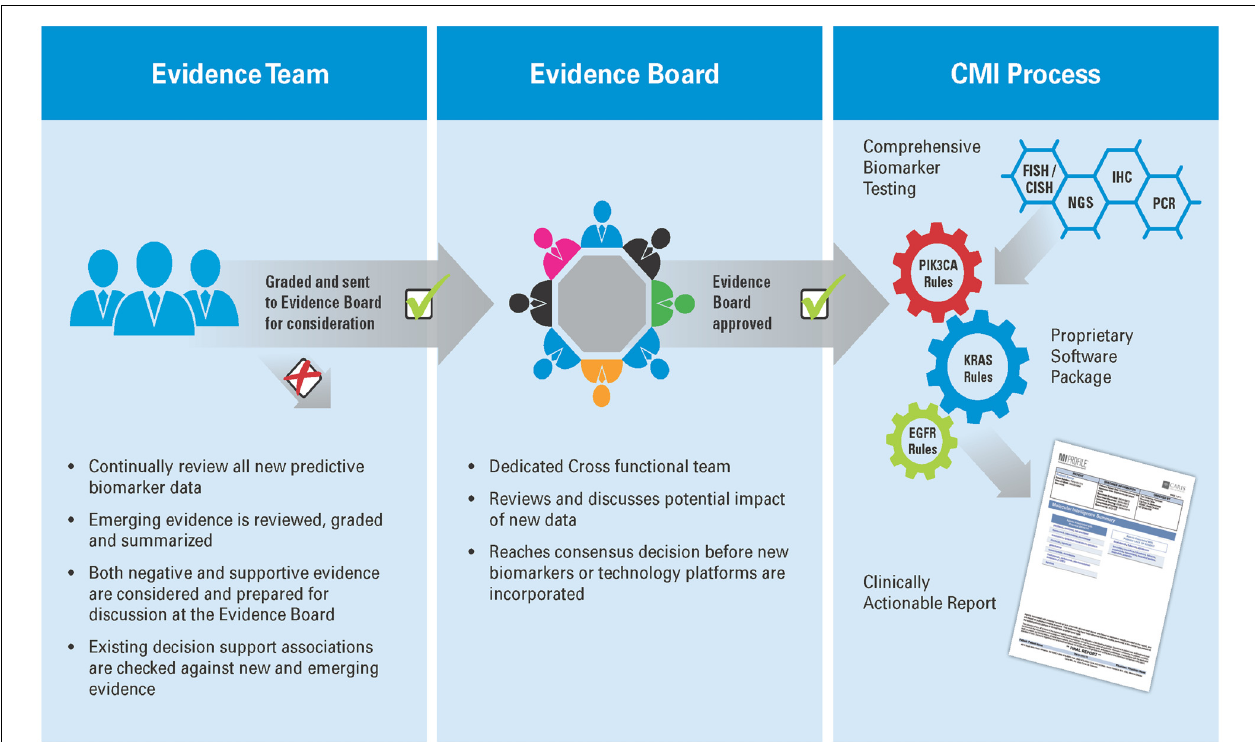
evidence review forms the basis of a proprietary software package which is used to translate the results of comprehensive biomarker testing to a clinically actionable report, providing physicians with meaningful biomarkers, actionable drug associations, and relevant clinical trials for their individual